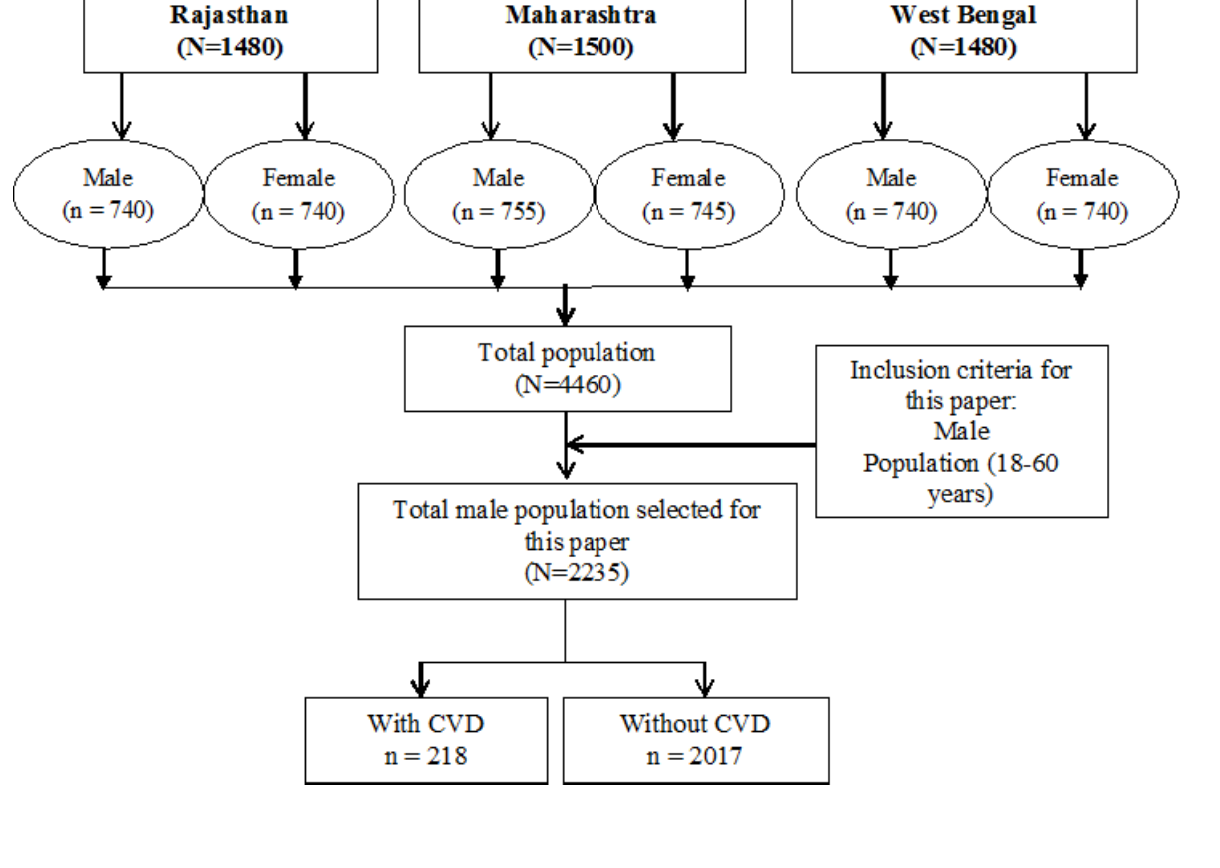
Figure 2. Sample selection